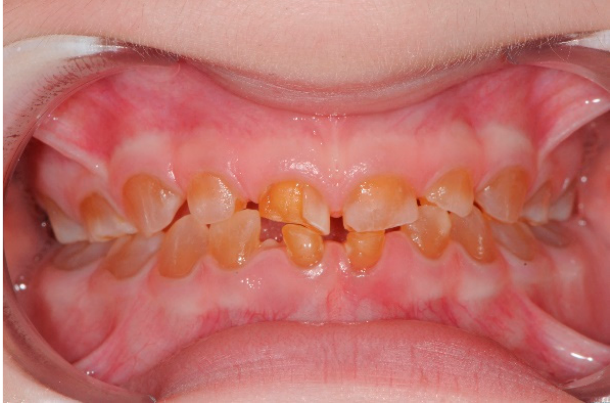
Figure 4. Temporal dentition in OI type I patient and dentinogenesis imperfecta.